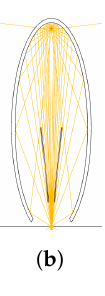
Figure 3. Visualisation of the optimised geometry and the related ray trajectories. ( a ) Optimised geometry according to simulations; ( b ) Ray trajectories according to ray-tracing